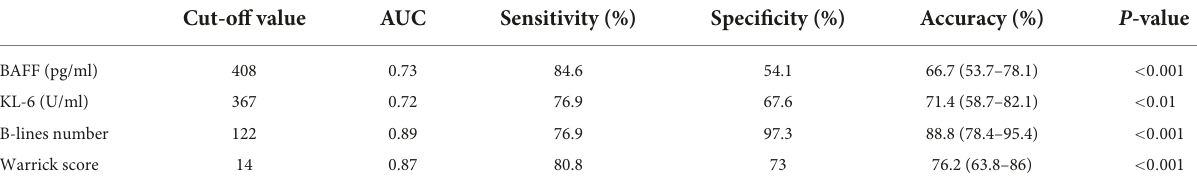
TABLE 2 Receiver operating characteristic analysis of BAFF, KL-6, B-lines, and Warrick score in discriminating F-ILD from